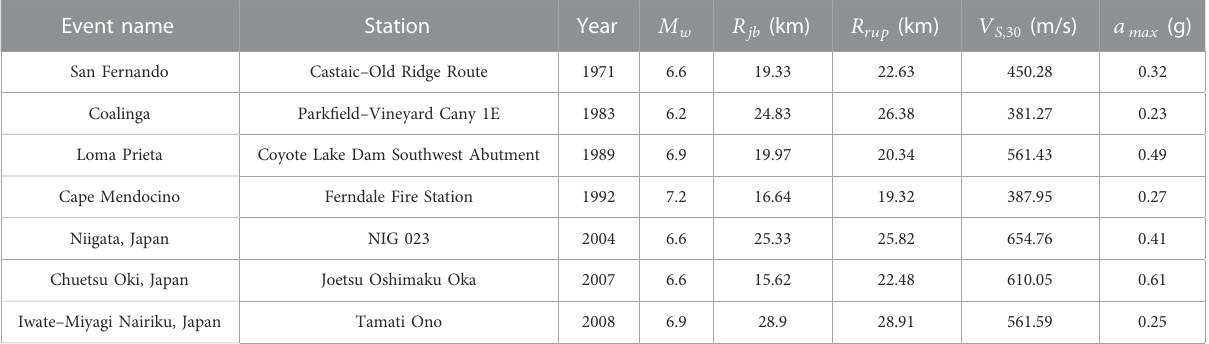
TABLE 1 Selected strong ground motion